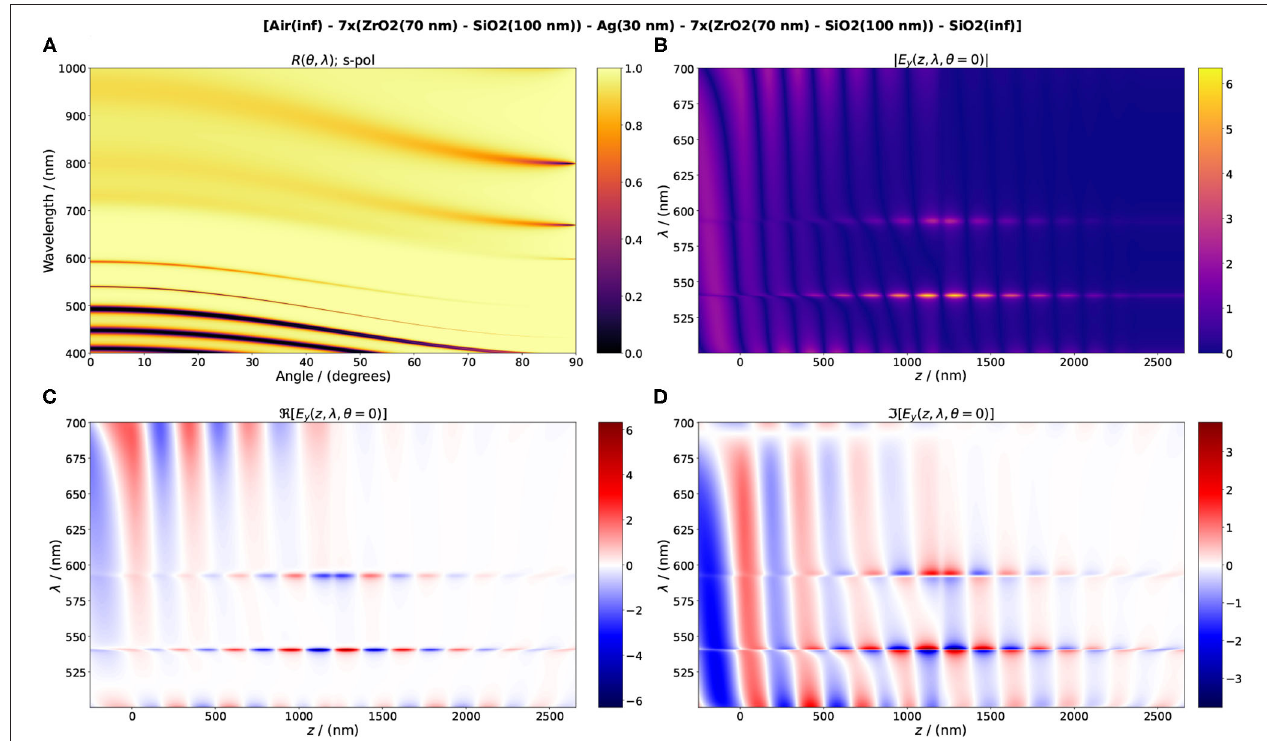
FIGURE 15 | Optical Tamm states in a symmetric structure constituted by two identical 7 unit cells photonic crystals and a central thin silver layer ( d Ag layers thickness in the unit cell of both PCs is approximately a quarter of the wavelength. Reflectance (A) ,